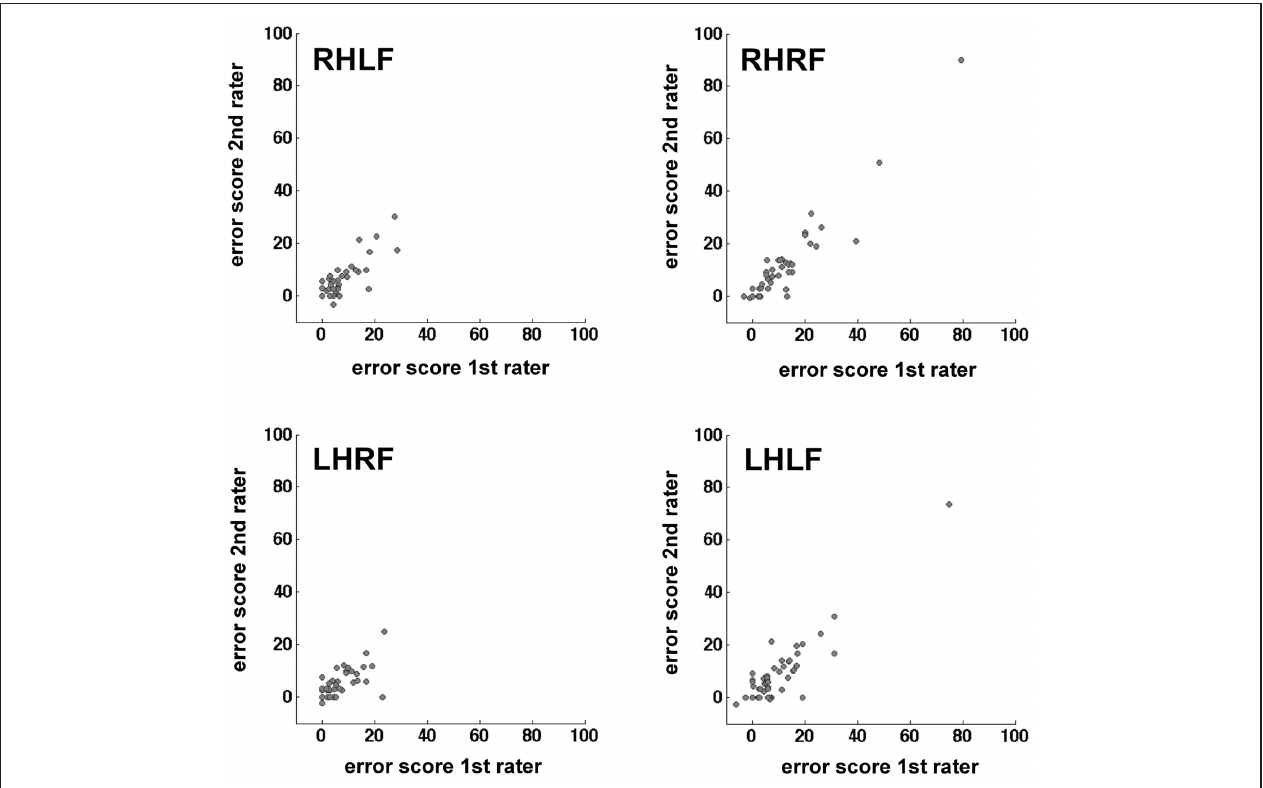
FIGURE 4 | Scatter plots mapping the correlation of the two raters per hand/field combination. Error scores are differences between percentage error scores in the fixation and saccade condition.